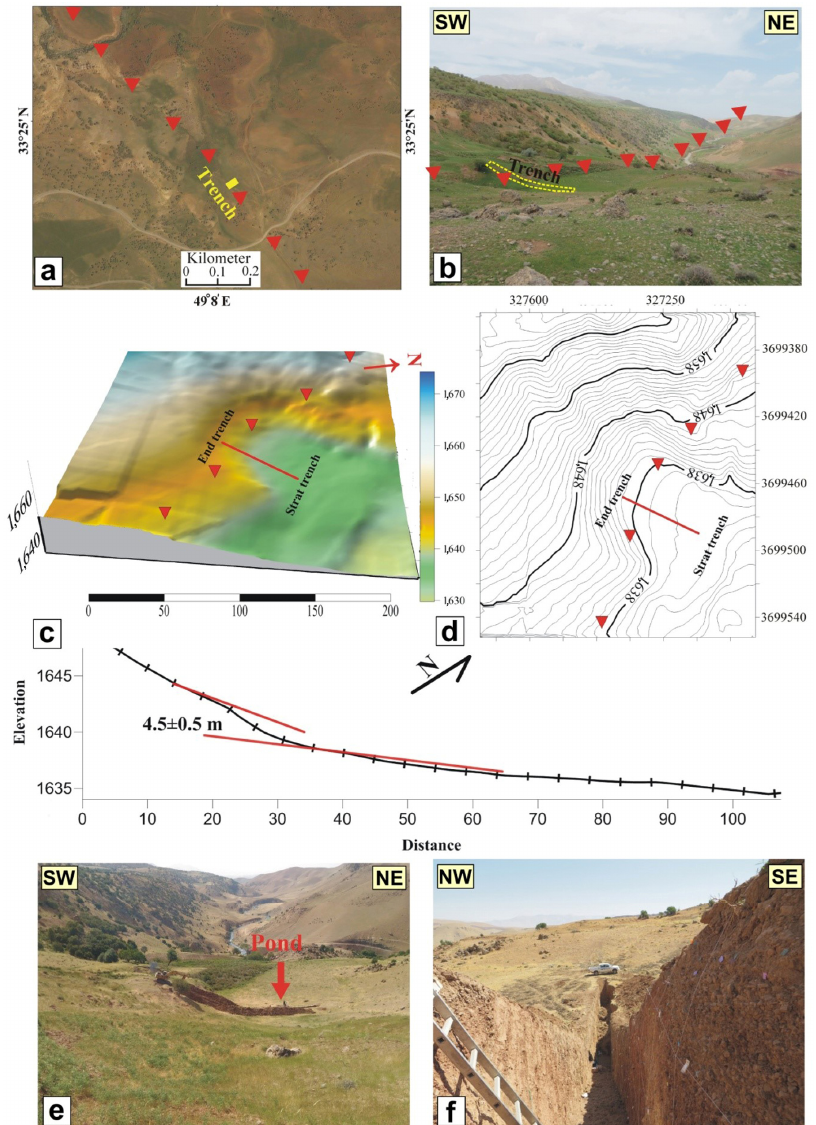
Figure 9. The location of the trench in the middle part of the Doroud Fault. Red triangles show the fault trace. The red triangles indicate fault trace. The red lines indicate the position of the cross-sections. ( a ) SASPlanet image of the fault trace and the excavated trench location for the paleoseismology studies. ( b ) Field photograph of the fault trace and the excavated trench location. ( c ) The 3-D model obtained of the GPS (RTK) surveying of the trench-digging area. ( d ) Topography map based on GPS measurements of the fault trace and excavated trench location (red line). ( e ) Note the component of apparent vertical movement (30.5 cm) ~4.5 m fault scarp obtained from the detailed topographical profiles. ( f ) Field photograph looking west along the fault, at the same time with excavation within the pond (red arrow), the fault trace marked by well-developed